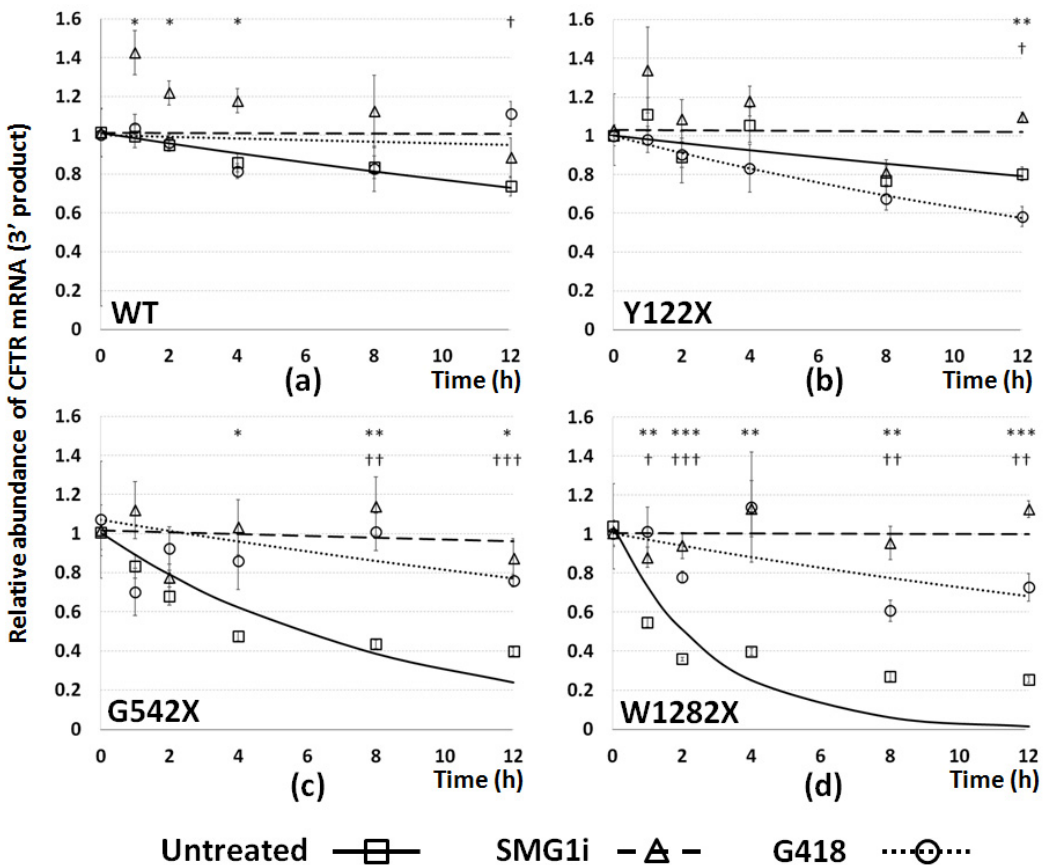
Figure 5. Effect of PTC mutations and of treatments on CFTR mRNA stability: 3 (cid:48) end. Degradation curves for CFTR mRNA were generated by RT-qPCR using the 3 (cid:48) CFTR primer pair following transcriptional shutdown using Actinomycin-D (5 µ g/mL) in 16HBE cells expressing ( a ) wt-, ( b ) Y122X-, ( c ) G542X-, or ( d ) W1282X-CFTR. RNA was extracted at timepoints between 0 and 12 h. Relative abundance of CFTR mRNA is represented on the y-axis, and time (h) following Actinomycin-D administration on the x axis. At the time of initial transcriptional shutdown, cells were either untreated (squares and solid regression curves) or treated with G418 (500 µ g/mL for 24 h: circles and dotted line) or SMG1i (1 mM, 24 h: triangles and dashed line). Observed data values are represented by shapes ( n = 3 ± SEM), and exponential degradation curves generated by best fit analysis overlaid. Significant differences between untreated cells and SMG1i (asterisks) and G418 (crosses) treatments are shown ( p < 0.05, 0.01, or